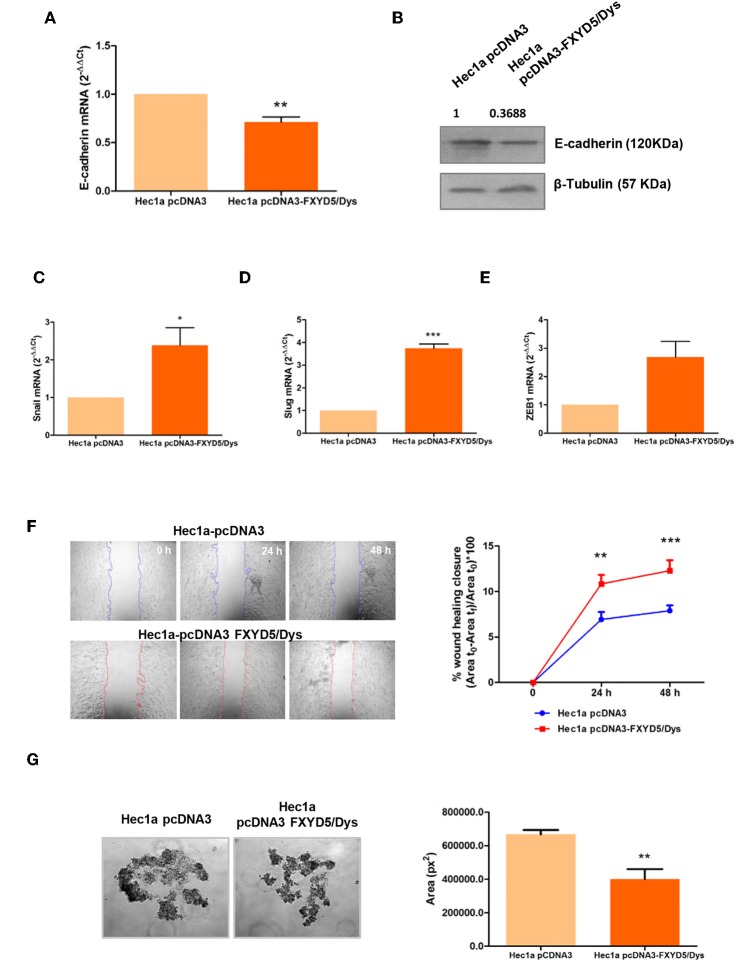
Modulation of FXYD5/Dys expression in Hec1a cells and changes in cell migration. (A) RT-qPCR analysis of E-cadherin mRNA expression in Hec1a cells transiently transfected with pcDNA3 empty plasmid (Hec1a pcDNA3 cells) or pcDNA3-FXYD5/Dys plasmid (Hec1a pcDNA3-FXYD5/Dys cells) (**P < 0.01, Wilcoxon signed rank test). (B) Immunodetection of E-cadherin by Western immunoblotting of Hec1a pcDNA3 and Hec1a pcDNA3-FXYD5/Dys cell protein extracts using anti-E-cadherin monoclonal antibody (610181, BD; 0.125 μg/ml). β-Tubulin (anti-β-tubulin monoclonal antibody D66; 0.5 μg/ml) was used as loading control. (C–E) RT-qPCR analysis of E-cadherin transcriptional repressors Snail (C) (*P < 0.05), Slug (D) (**P < 0.01), and Zeb1 (E) (P = 0.055) (Wilcoxon signed rank test). (F) Left panel: Wound healing assay of Hec1a pcDNA3 and Hec1a pcDNA3-FXYD5/Dys cells. Representative images of cells at 0, 24, and 48 h post-transfection are shown (magnification 40×). Right panel: Free-cell area was quantified using ImageJ software, and the wound healing closure percentage was plotted at every time point (**P < 0.01, ***P < 0.0001, two-way ANOVA, Bonferroni post-test). (G) Left panel: Hanging drop assay of Hec1a pcDNA3 and Hec1a pcDNA3-FXYD5/Dys cells. Representative images of cell aggregates at 48 h are shown (magnification 100×). Right panel: Cell aggregate area was quantified using ImageJ software, and mean cell aggregate areas (expressed as squared pixels) were plotted and compared (**P < 0.01, Mann–Whitney test).